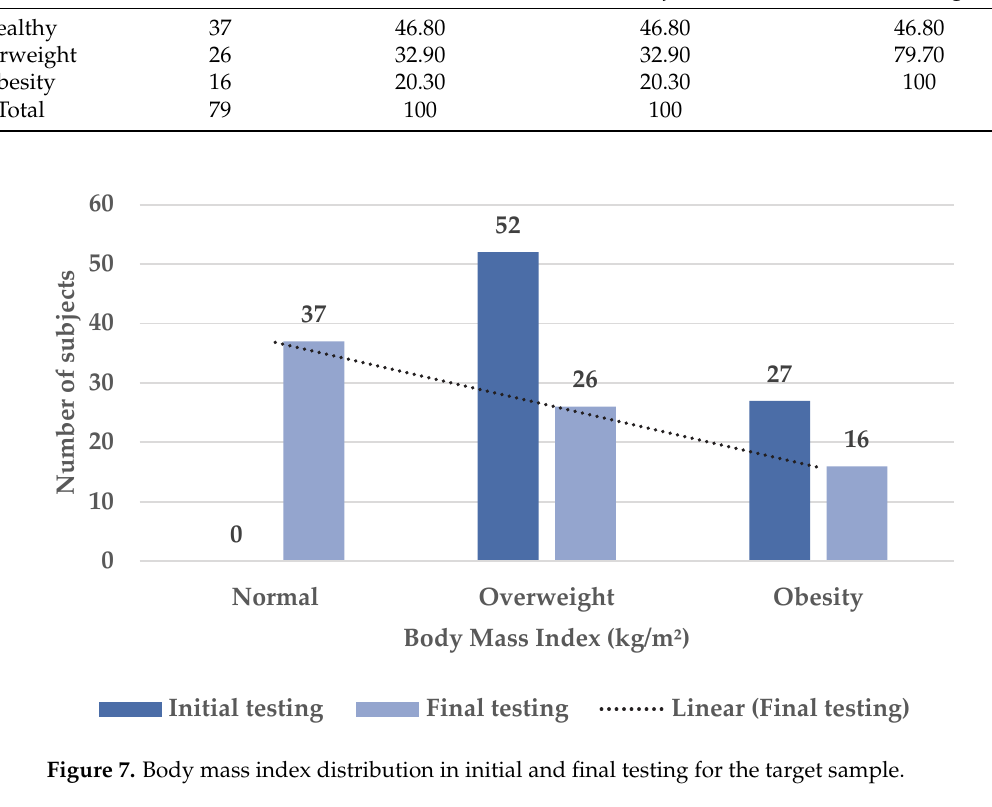
Figure 8. Distribution of initial and final body mass indices for the target sample by gender.